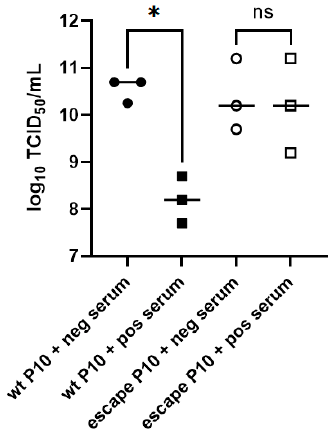
Figure 2. Passage of F52/70 in sub-neutralizing concentrations of anti-2512 serum led to immune escape in DT40 cells. The F52/70 virus that was passaged 10 times in serum lacking IBDV antibodies (wt P10), and the F52/70 virus that was passaged 10 times in anti-2512 serum to generate an escape mutant (escape P10), were titrated in triplicate in the presence of either negative control serum (neg serum) or anti-2512 serum (pos serum) at a dilution of 1:100. The virus titer was quantified, expressed as log 10 TCID 50 /mL, and plotted on the y axis. A one-way ANOVA with Tukey post hoc comparisons was conducted, and results were considered significantly different when p < 0.05 (*), ns = “not